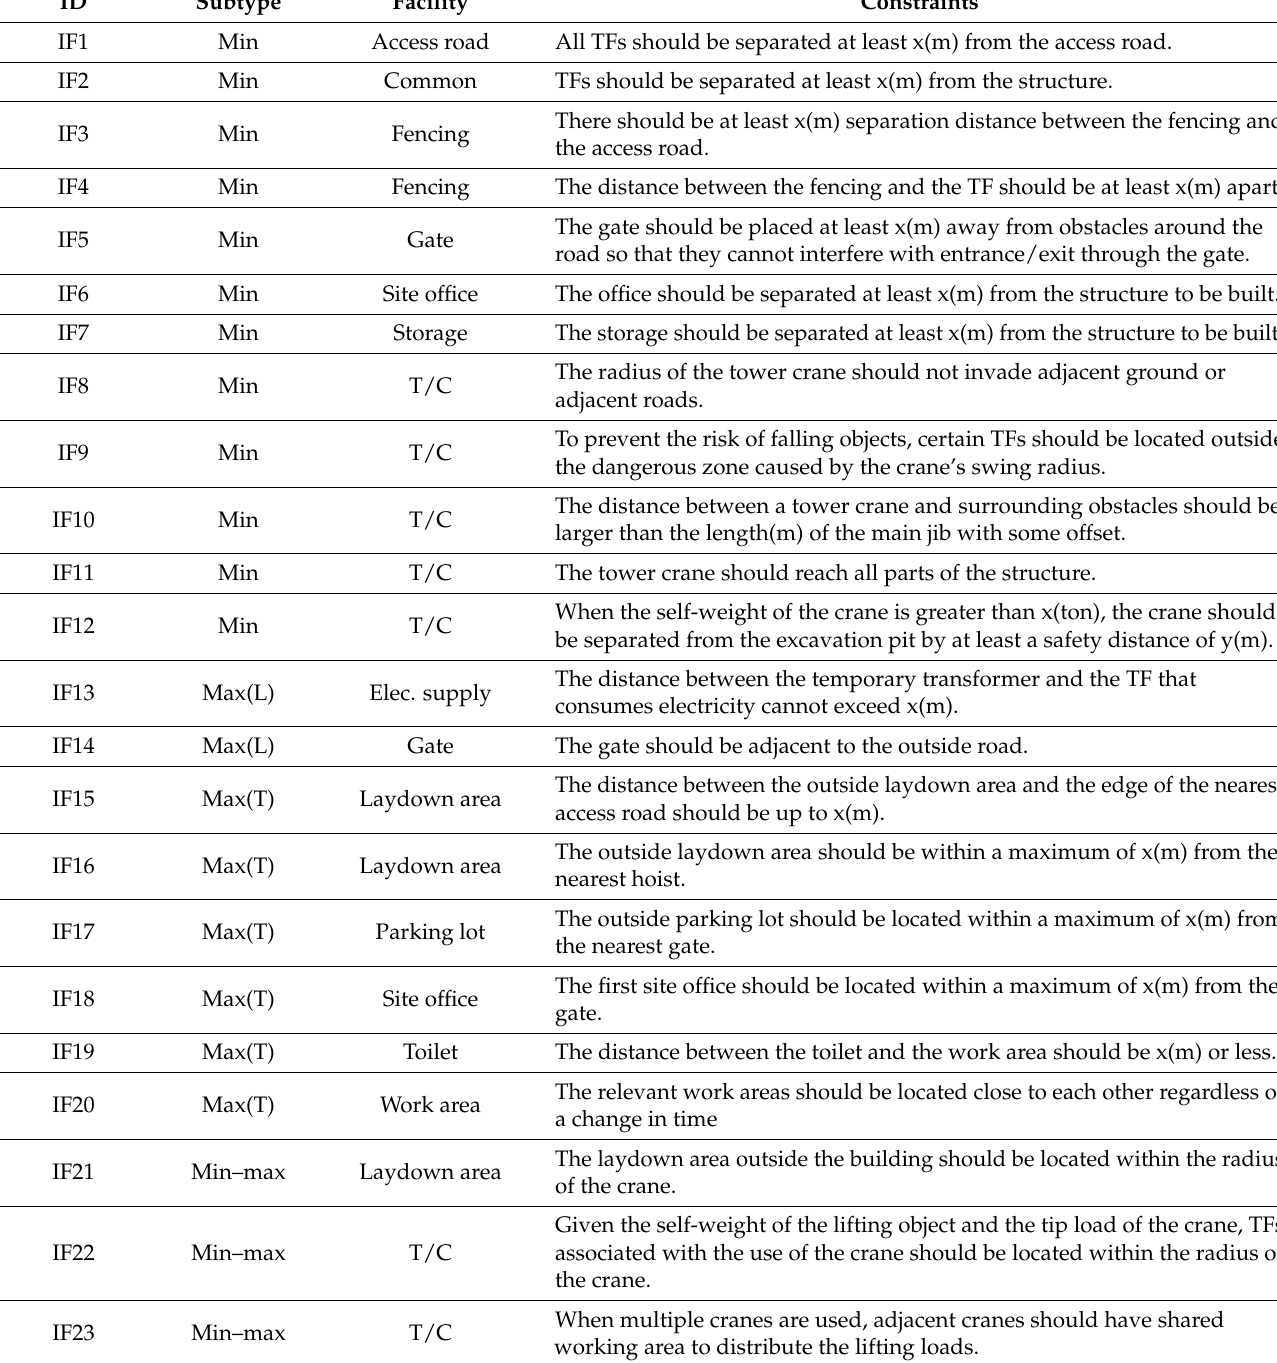
Table 5. Inter-facility distance constraints identified in this